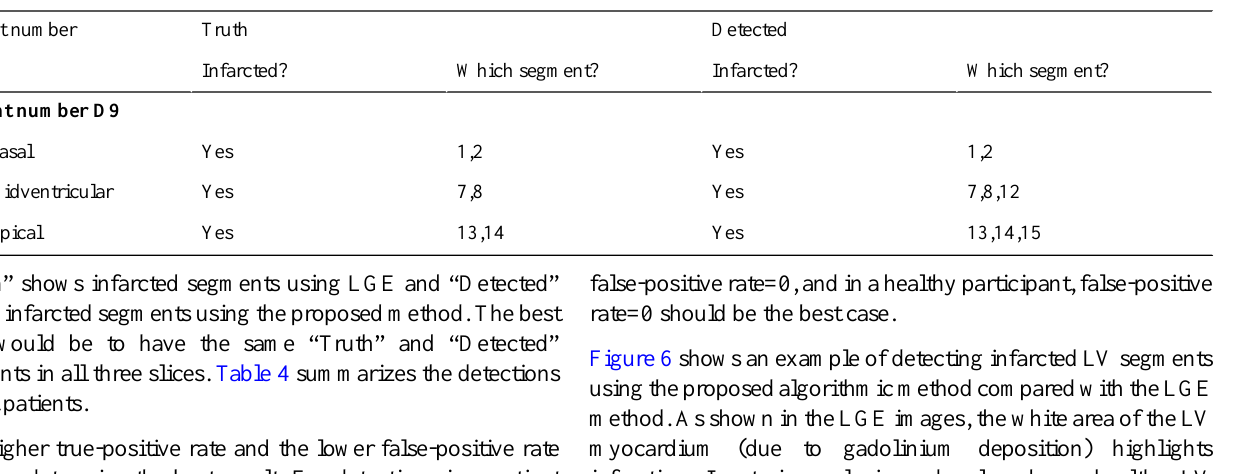
Table 3. Analysis of a myocardial infarction patient. Truth and Detected show the results of late gadolinium enhancement and the proposed method,